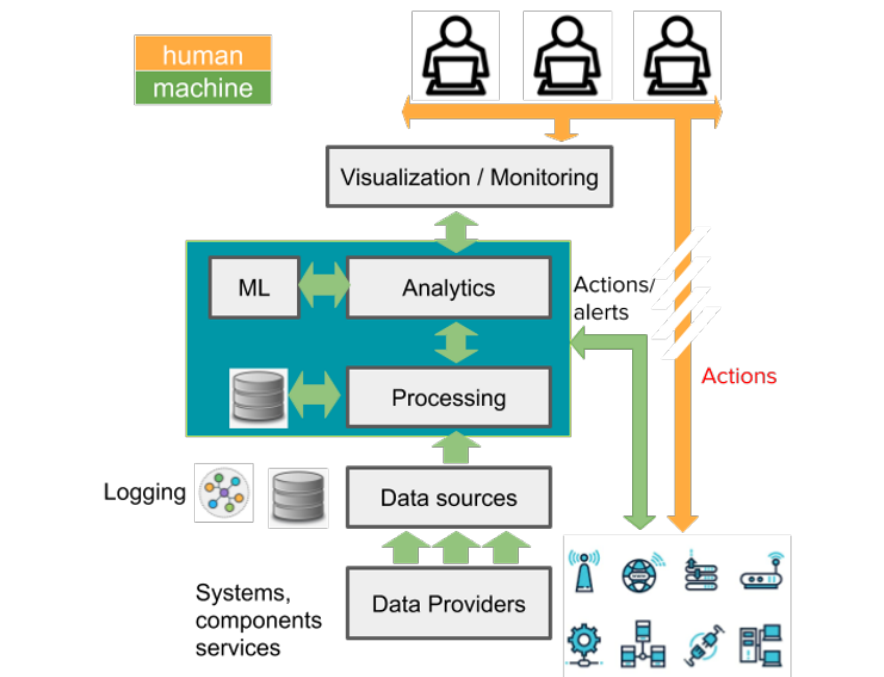
Figure 1. The proposed architecture of the Op Int